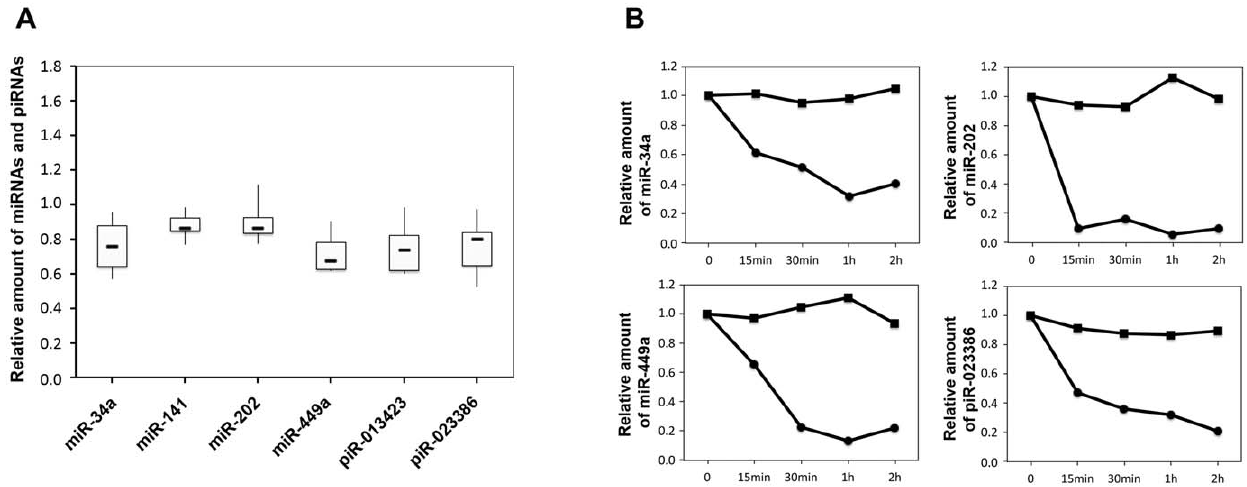
Figure 4. Most cfs-miRNAs remained in the supernatant and were dramatically degraded by intense protease K digestion. The amount of miRNAs in the supernatant (A) was normalized to the seminal plasma. Horizontal lines within the boxes denote the median (n=6). The boxes and whiskers represent intervals between the 25th to 75th percentiles, and the 2.5th to 97.5th percentiles, respectively. For protease K digestion (B), at each time point, the supernatant incubated with 0.5% (w/v) protease K (circle dots) or not (square dots) was subjected to miRNA quantification. The amounts at time 0 were taken as 1.0.